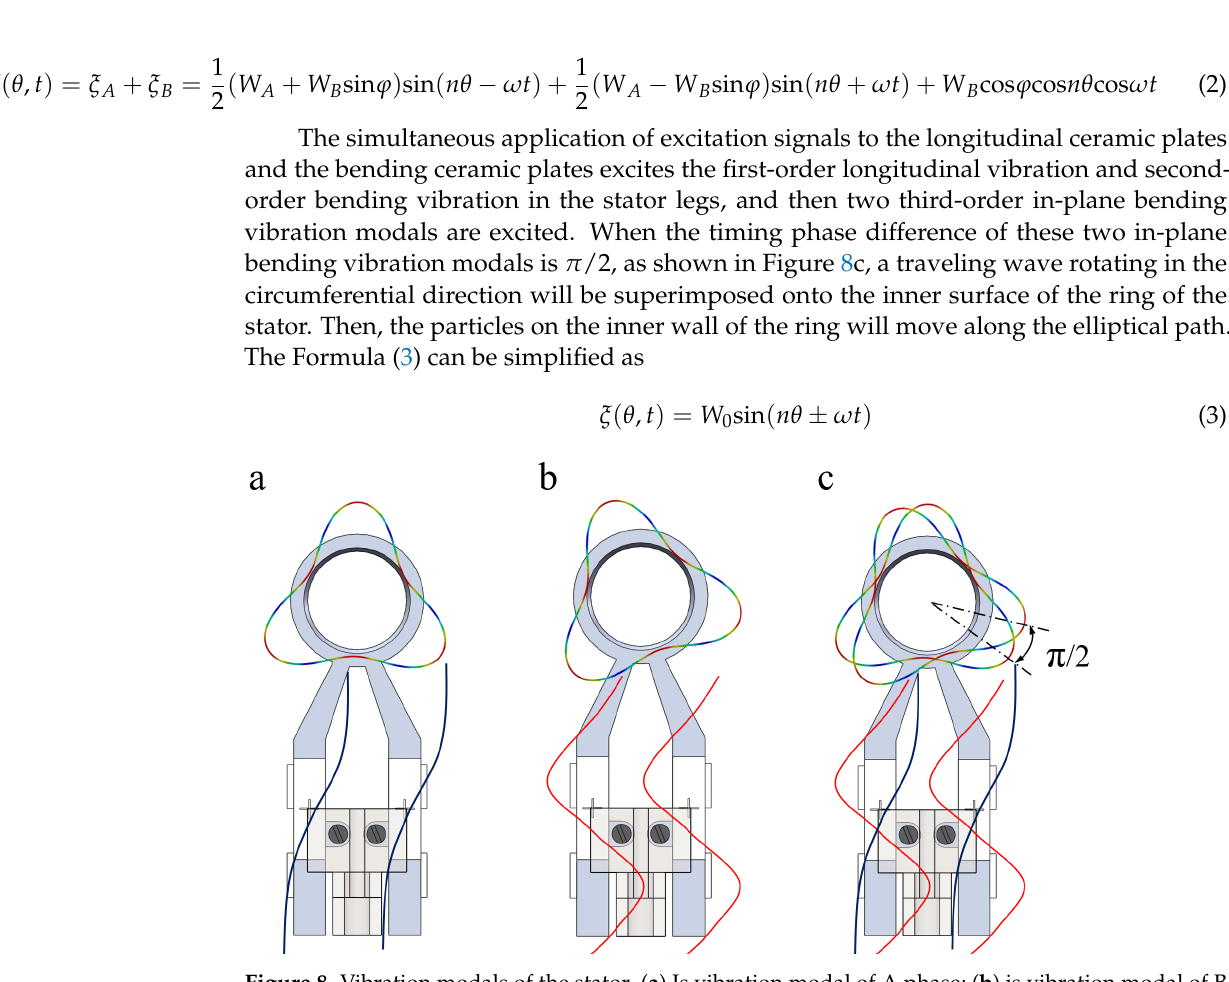
Figure 8. Vibration modals of the stator. ( a ) Is vibration modal of A phase; ( b ) is vibration modal of B phase; ( c ) is the combination of these two vibration modals.